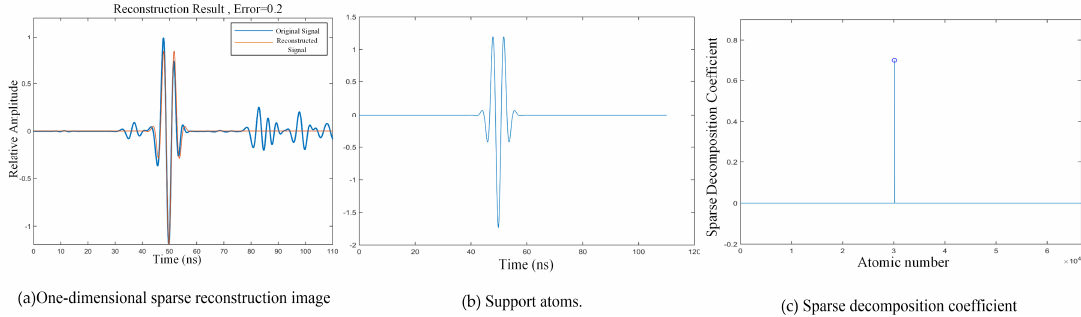
Figure 9. Time domain signal and supporting set atoms of one-dimensional sparse reconstruction, threshold of 0.2.